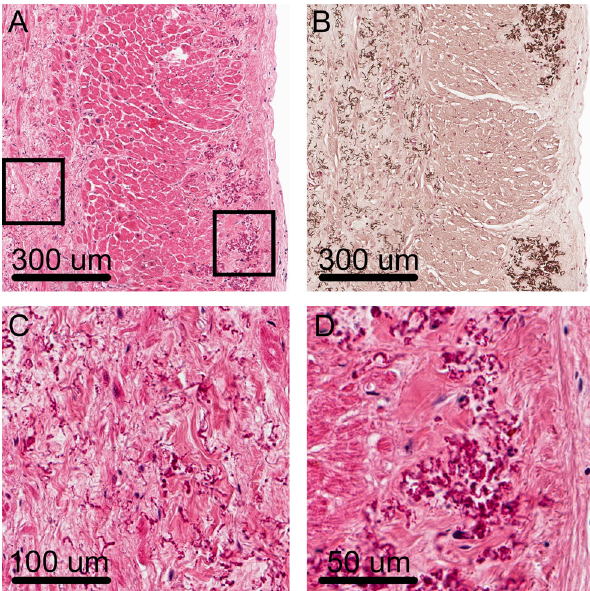
Fig. 2 Elastic fibre alterations in the heart. a Degenerated and calcified fibres were mainly found below the endocardial layer (right side of the picture). Furthermore, similar fibres were seen in the interstitial fibrous tissue in the myocardium (left side of the picture). b Von Kossa stain showing the calcified elastic fibres. c Enlarged picture of the abnormal elastic fibres within the interstitial fibrotic tissue in the myocardium. d Enlarged picture of the abnormal elastic fibres in the subendocardial